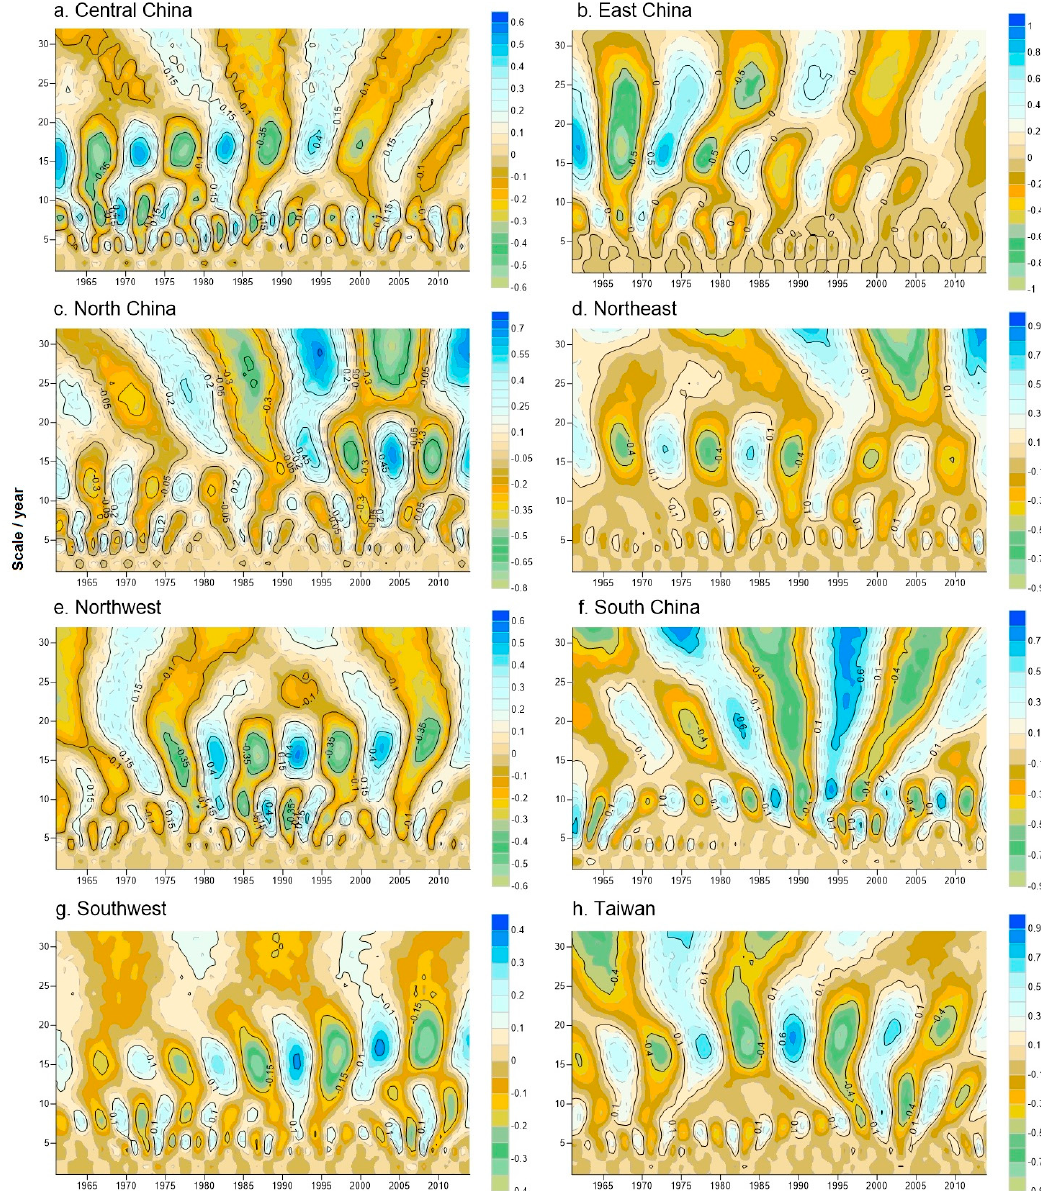
Figure 7. Wavelet coefficient counter map of SPI in China for 1961–2014 in ( a ) central China; ( b ) east China; ( c ) north China; ( d ) northeast; ( e ) northwest; ( f ) south China; ( g ) southwest; and ( h ) Taiwan.